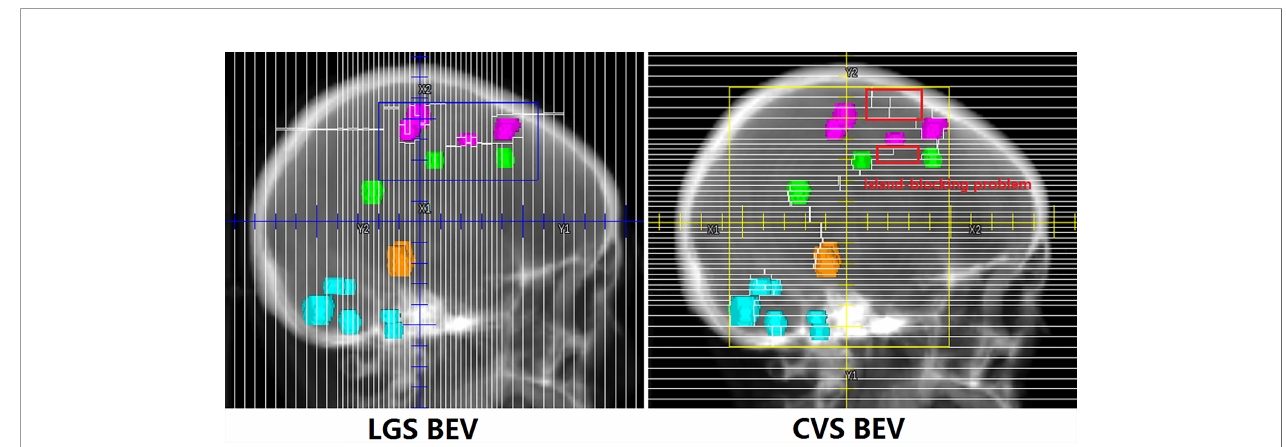
FIGURE 4 | One segment of LGS and CVS in BEV. The control points in the LGS plan are shaped like narrow strips that do not have the island-blocking problem. However, in the CVS plan, the issues of the island-blocking problem and large jaw opening inevitably arise.